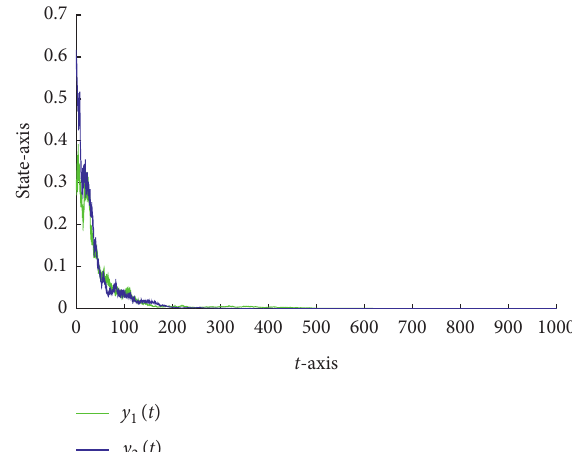
Figure 4: The extinction of model ( M ) with c